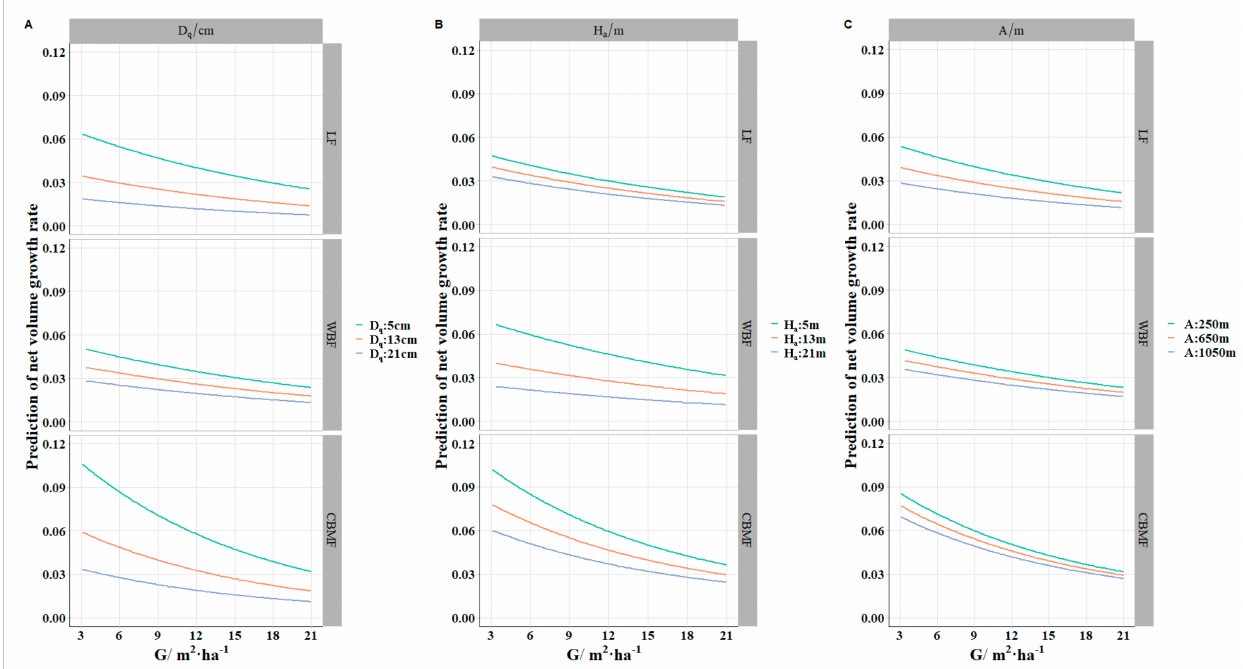
Figure 5. The relationship between RGR nv and G at three different levels of D q ( A ), H a ( B ), and A ( C ); the mean values of D q , H a , and A are 11.1 cm, 12.2 m, and 625.9 m for LF; 12.8 cm, 13.1 m, and 635.3 m for WBF; and 12.2 cm, 13.1 m, and 601.9 m for